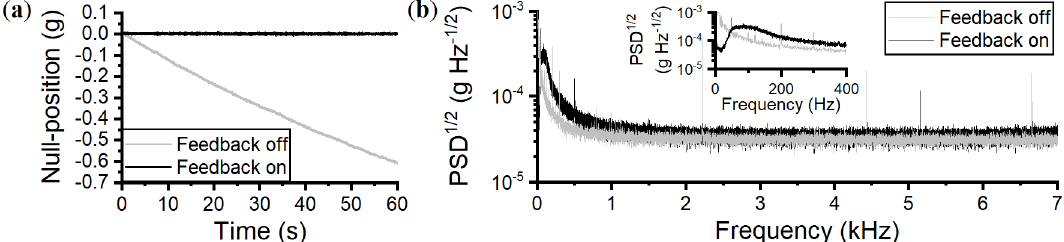
Figure 5. ( a ) Without feedback, creep from the PZT gradually creates a false acceleration bias as well as a change in scale-factor. To minimise scale-factor variation and enable long operation times, a simple proportional feedback was applied. ( b ) The PSD of the WGM signal with and without feedback shows the reduction in low frequency noise below 60Hz but with a slight increase in the overall noise